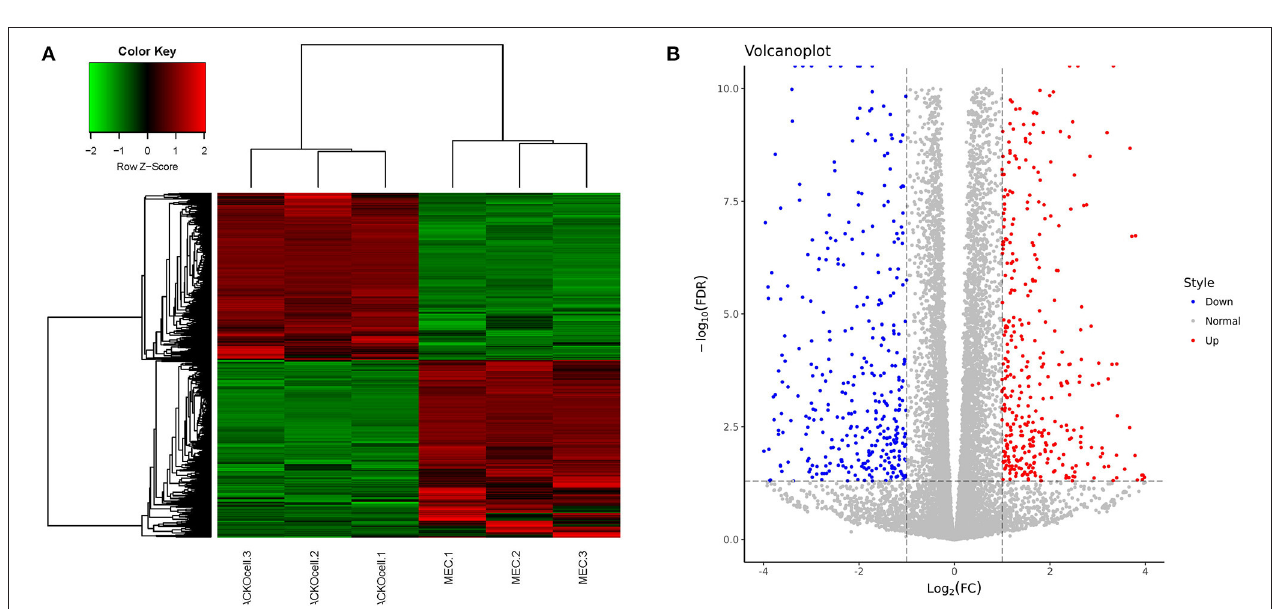
FIGURE 3 | Identification of DEGs in WT and ACADSB − / − bMECs by RNA-seq. (A) Hierarchical clustering heatmaps of WT and ACADSB − / − bMECs. (B) Volcanoplot of WT and ACADSB − / − bMECs.